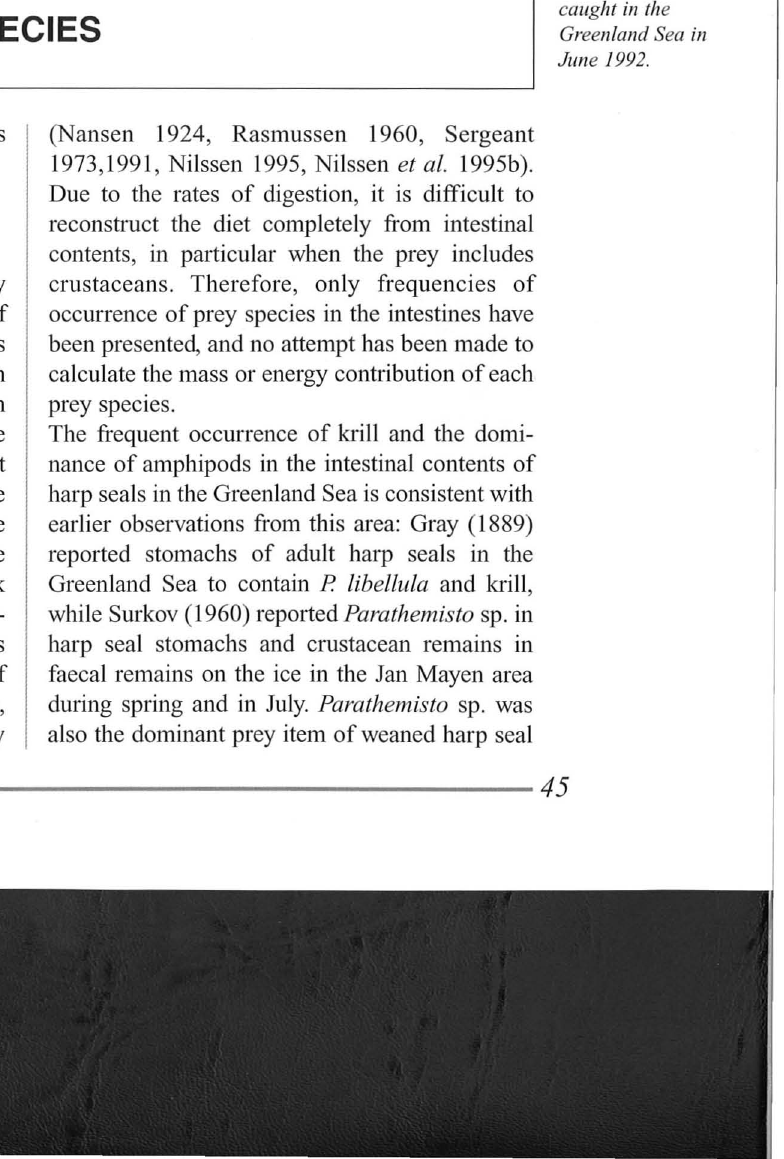
Fig. 4 . Relative occur rence in terms of cet/culated bulk biomass of prey species in stomach contents of 10 adult hooded seals caught in the Greenland Sea in June